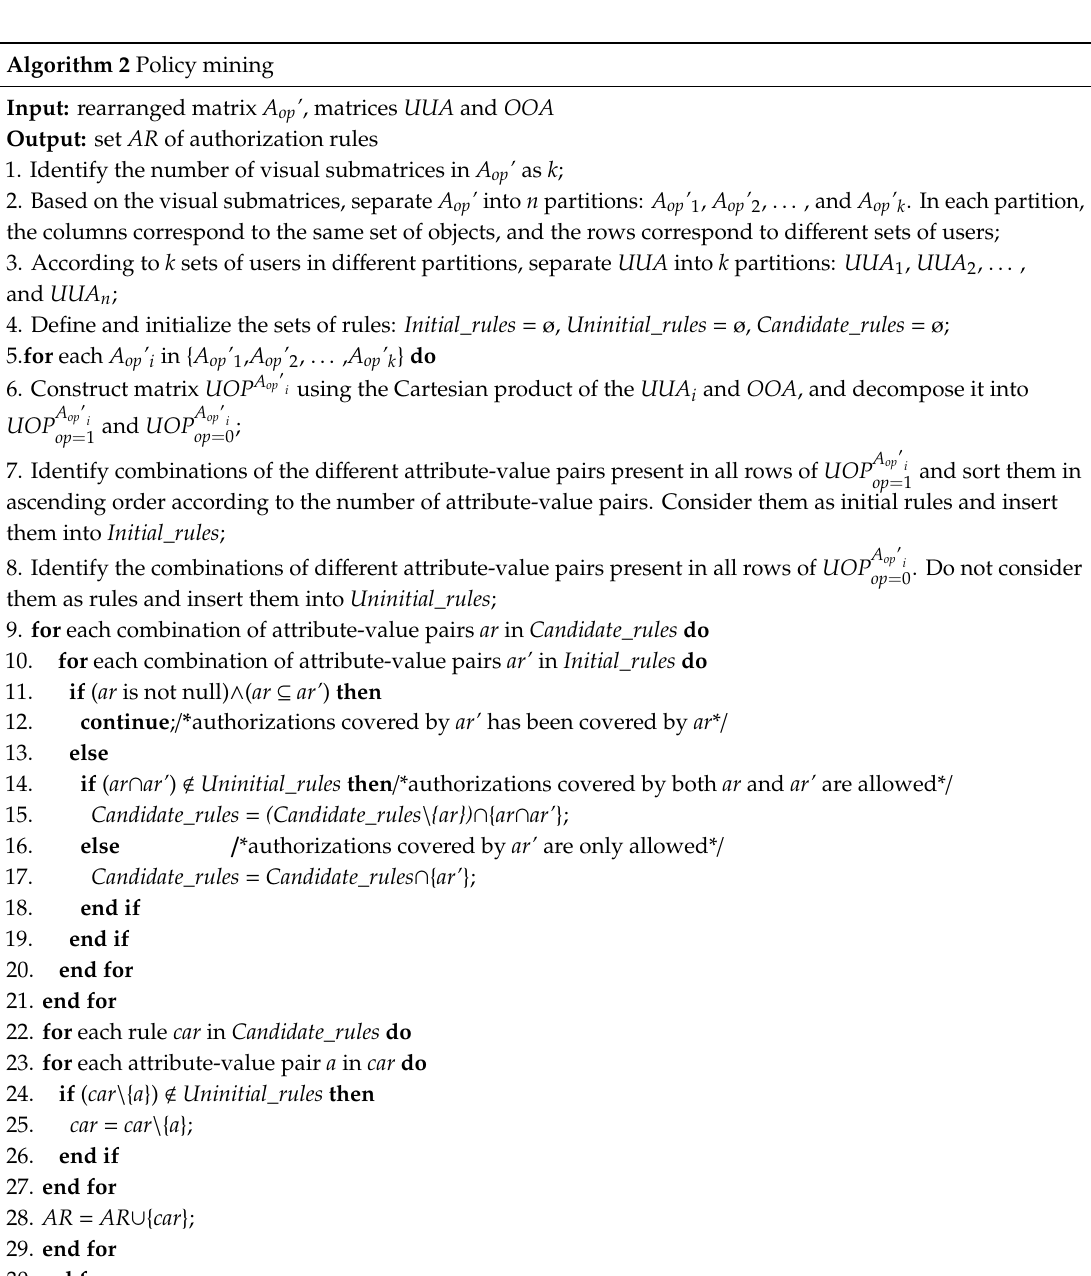
Algorithm 2 Policy